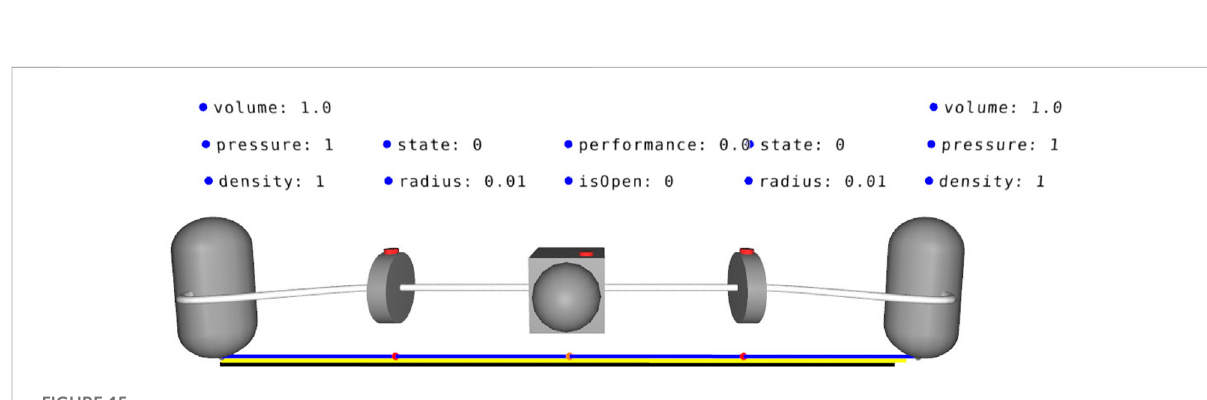
FIGURE 15 Simple hydraulics simulation to test causal discovery using machine